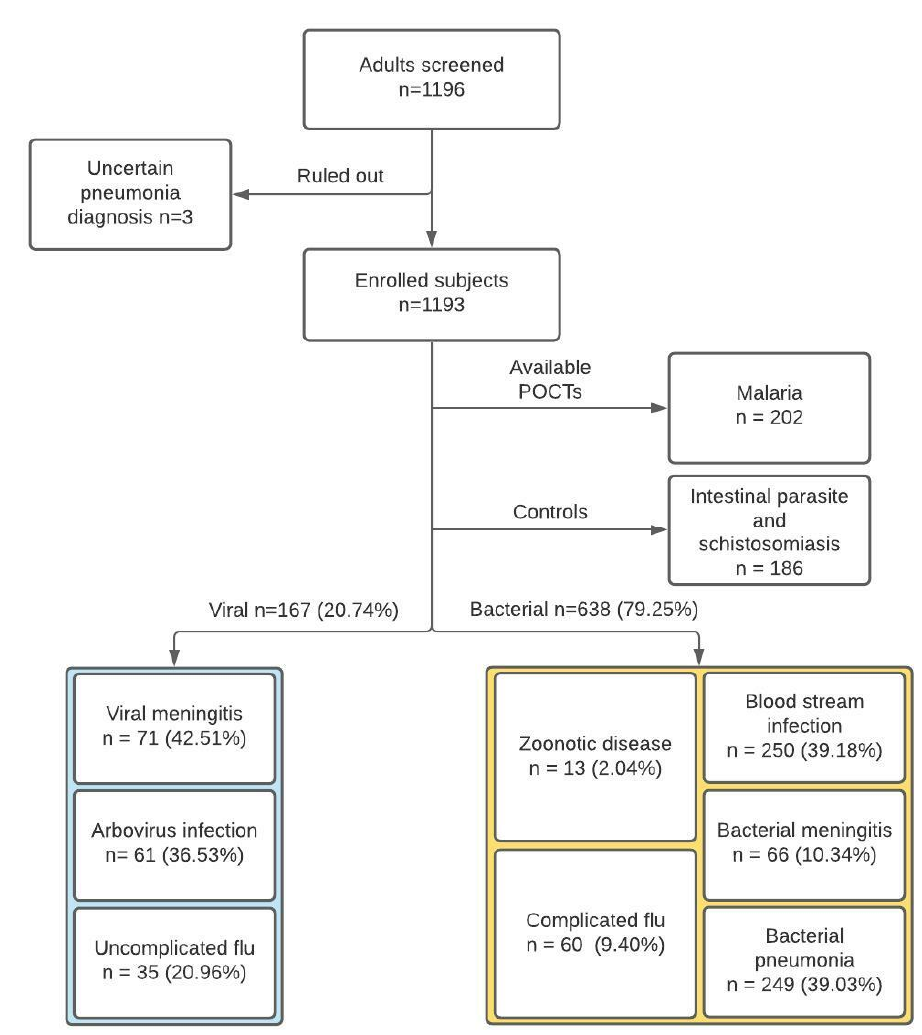
Figure 1. Study flow chart.